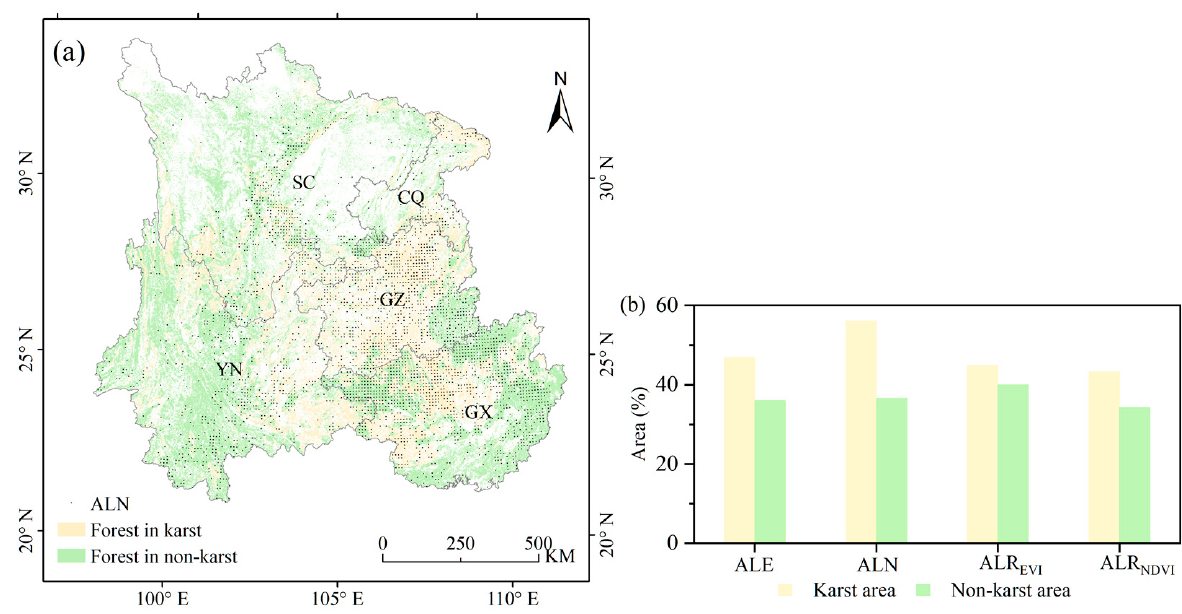
Figure 8. ( a ) The spatial distributions of ALN, karst and non-karst areas in 2012; ( b ) the area proportions of ALE, ALN, ALR EVI and ALR NDVI of forest between karst and non-karst areas in 2012. The abbreviation: CQ (Chongqing), SC (Sichuan), GZ (Guizhou), YN (Yunnan) and GX (Guangxi).